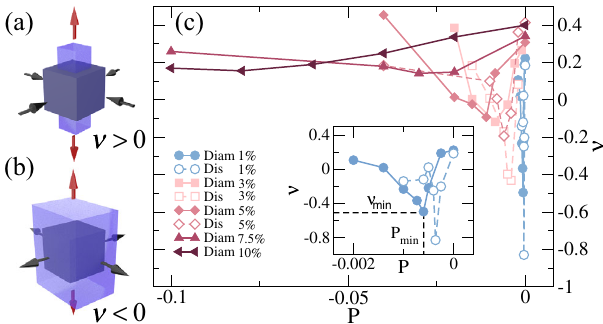
Fig. 1 Auxetic behavior of ordered and disordered hydrogels. Illustration of ( a ) standard ( ν > 0) versus ( b ) auxetic ( ν < 0) behavior. Here, the red arrows indicate the uniaxial deformation (stretching) that is applied on the initial state of the system, represented by the dark cube that is identical in both cases. Following external strain, the system deforms perpendicularly in the directions indicated by the black arrows, leading to two different fi nal states, represented by the light polyhedra; ( c ) calculated Poisson ’ s ratio ν as a function of negative pressure P for different values of crosslinker concentration c = 1, 3, 5, 7.5% both for ordered (Diam, full symbols) and disordered (Dis, empty symbols) networks. Inset: zoom of c = 1%, where the minimum values of pressure and Poisson ’ s ratio, P min and ν min , respectively, are indicated for the Diam-1% case. Pressure is given in units of k B T / σ 3 as described in Methods. Source data are provided as a Source Data fi